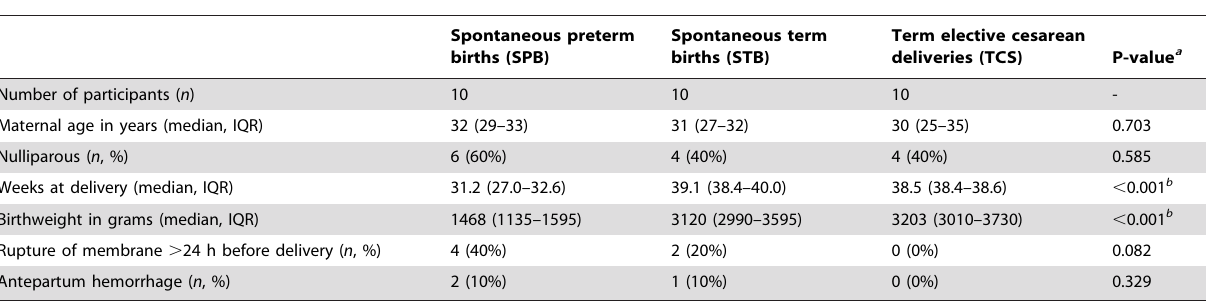
Table 1. Characteristics of participants in the analysis of placental tissues.